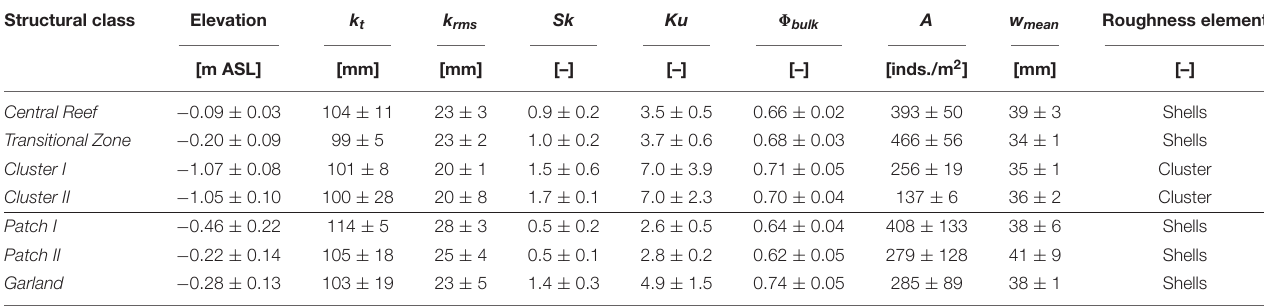
FIGURE 7 | Histograms based on surface level elevation z [mm] illustrating the probability density functions (PDFs) [-] of all samples distinguished by their structural classes. Top row: homogenous structural classes; Bottom row: enclosed structural classes. The PDFs are centered around the zero mean. The colors indicate the individual samples as presented in Figure 5 , e.g., blue: CR1, orange: CR2, yellow: CR3, etc. TABLE 3 | Average statistical parameters per proposed structural class, where k t is the total roughness height, k rms is the root-mean-square roughness height, Sk is the skewness, Ku is the kurtosis, (cid:56) bulk is the bulk porosity, A is the abundance, w mean is the mean width of the oyster